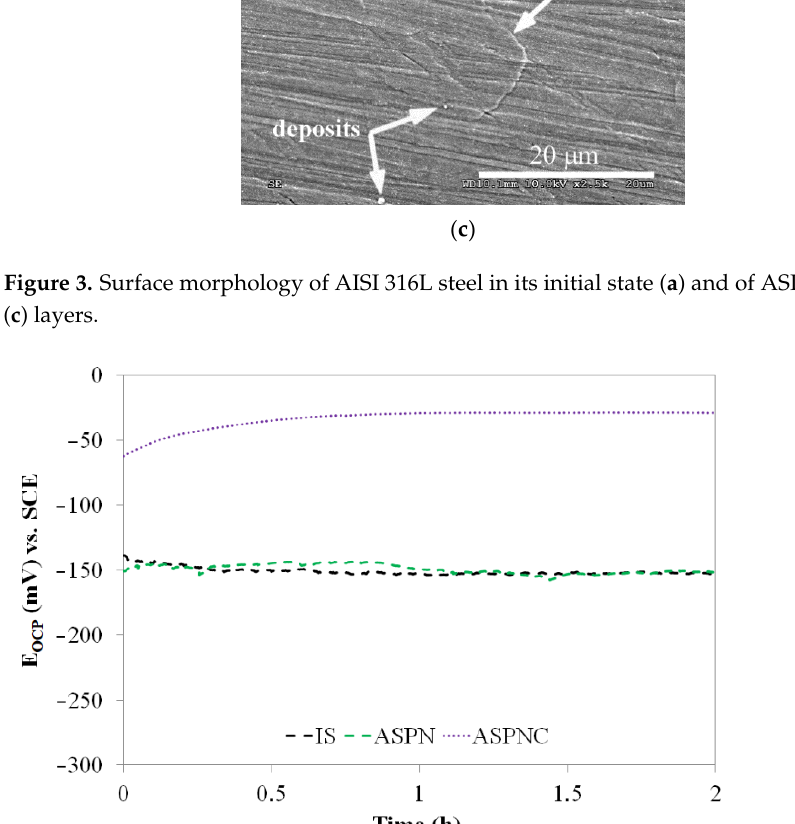
Figure 3. Surface morphology of AISI 316L steel in its initial state ( a ) and of ASPN ( b ) and ASPNC ( c ) layers.